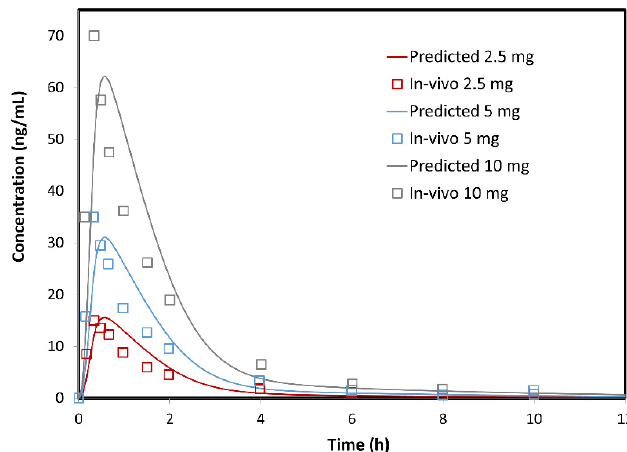
Figure 9. The simulated (lines) and mean in-vivo observed (markers) plasma concentration profiles following oral administration of different minoxidil doses. In-vivo data are taken from [10].